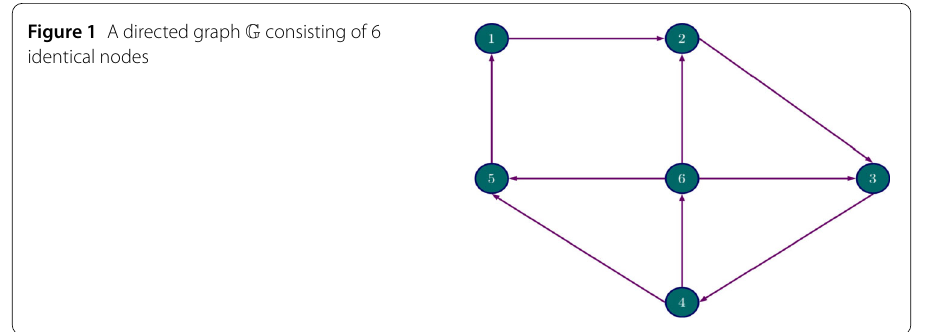
Figure 1 A directed graph G consisting of 6 identical